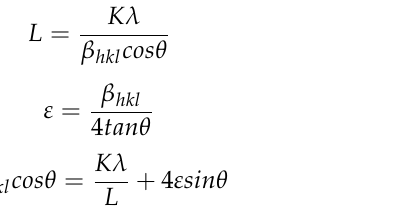
by the equation shown in (4), which provides the effect of intrinsic strain associated with crystal size [28–31].